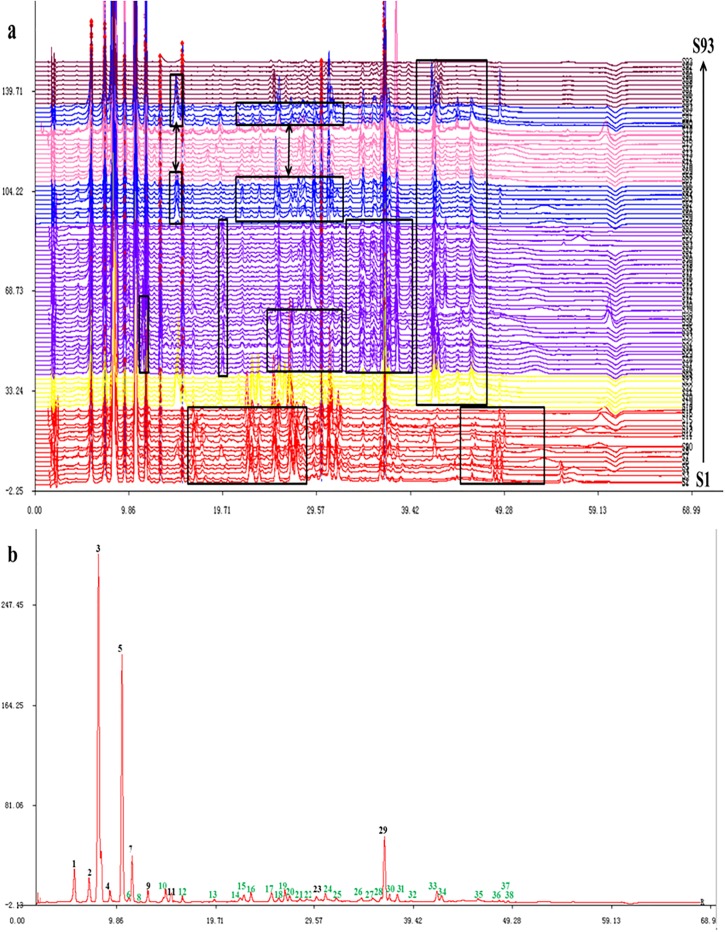
(a) HPLC fingerprints of the 93 Cortex Daphnes samples (S1-S93) and (b) reference chromatogram.4: Syringoside 5: Daphnetin 9: 7-hydroxycoumarin.